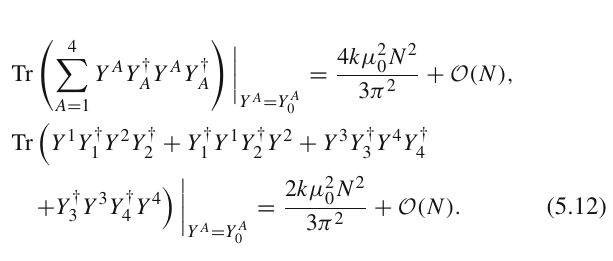
Fig. 2 Validity of the holographic renormalization for the CPO of con- formal dimension (cid:2) = 2 in the square-shaped Young diagram of the LLM geometries at large N . The vertical axis is K ( N ) = (cid:2) O with N = 4 , 9 , 16 , ··· ,